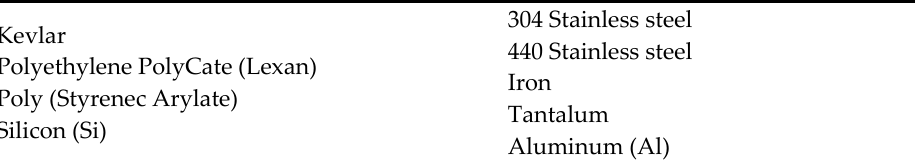
Table 1. List of DLC-compatible